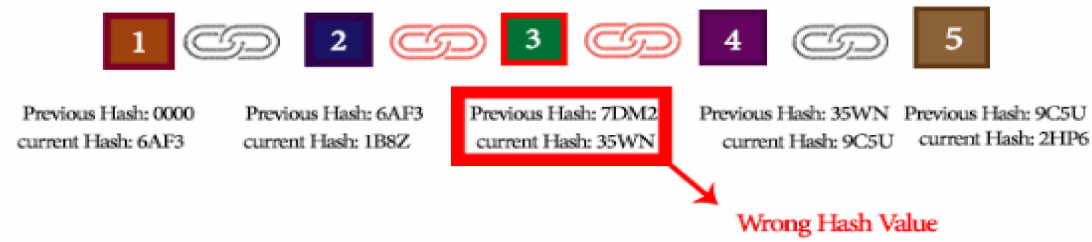
Figure 9. Sample blockchain planning for partial nodes in unusual WSNs.